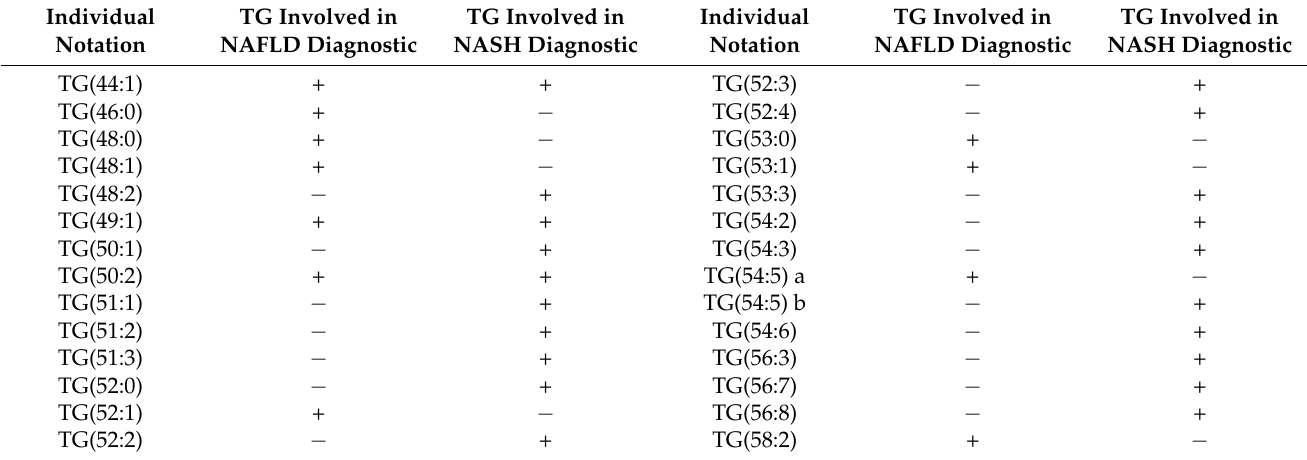
Table 1. Noninvasive serum triglyceride biomarkers in NAFLD and NASH. Triglycerides (TG) that participate in the model for the discrimination between NAFLD and normal liver (NL) and/or between NASH and NAFL (simple steatosis) are represented as